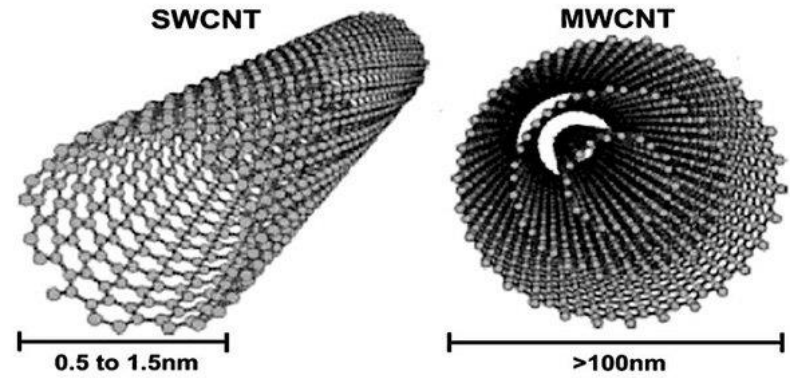
Figure 11. Schematic overview of single-walled nanotubes (SWNTs) and multi-walled nanotubes (MWNTs) [Reproduced from [109] with license CC BY 4.0, Copyright 2017].